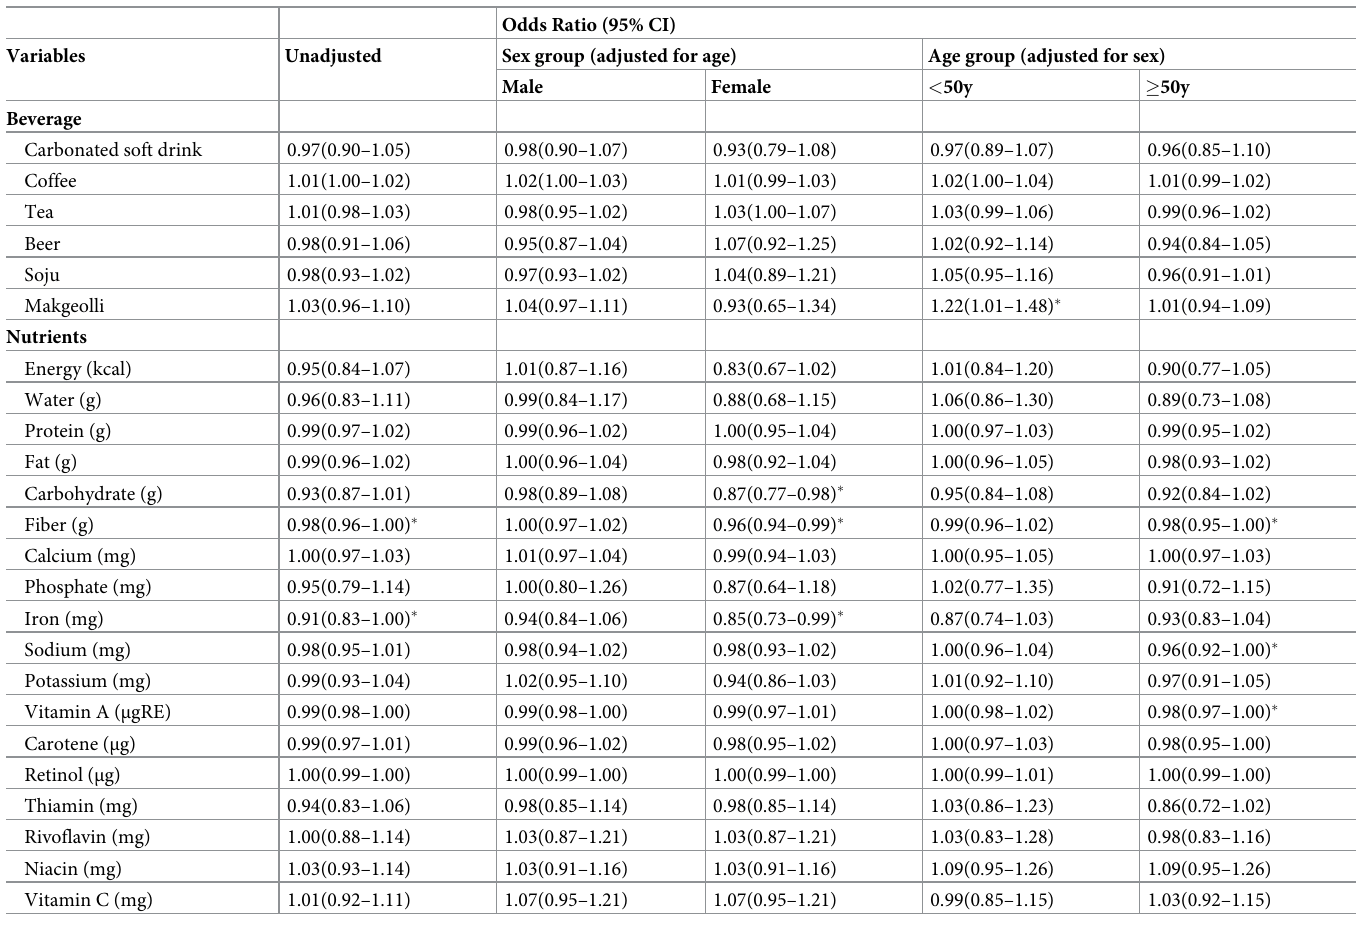
Table 4. Dietary factors by nutrients associated with inflammatory laryngeal disease in